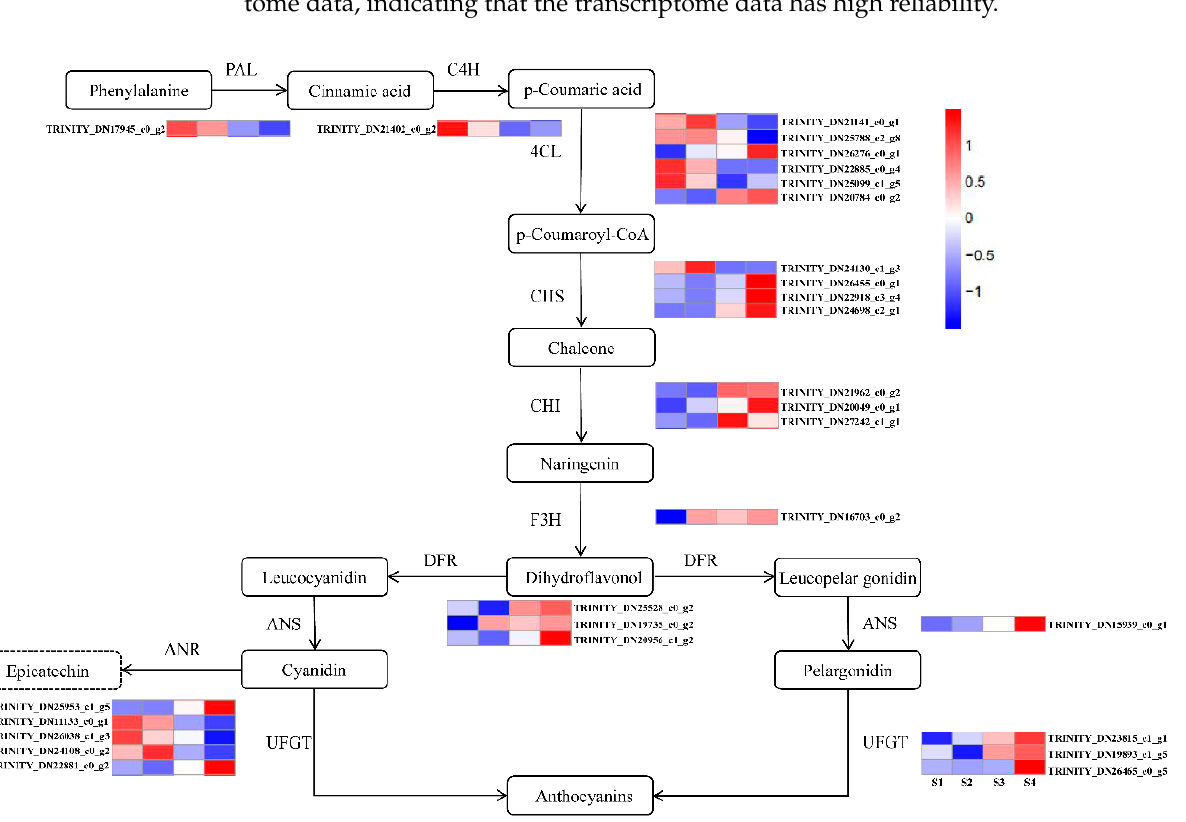
Figure 4. Anthocyanin biosynthetic pathway and their genes expression levels in fruit peel development. Blue and red in the heatmap represent the down- and up-regulated structural genes, respectively. Differentially expressed genes including phenylalanine ammonia-lyase ( PAL ), cinnamate 4-monooxygenase ( C4H ), 4-coumarate-CoA ligase ( 4CL ), chalcone synthase ( CHS ), chalcone isomerase ( CHI ), flavanone-3-hydroxylase ( F3H ), dihydroflavonol 4-reductase ( DFR ), anthocyanidin reductase ( ANR ), anthocyanidin synthase ( ANS ) and UDP-glucose: flavonoid-3- O -glycosyltranferase ( UFGT ). Four colored boxes showed the relative gene expression level measured by RNA-seq (average value). Gene names are listed in Table S3.